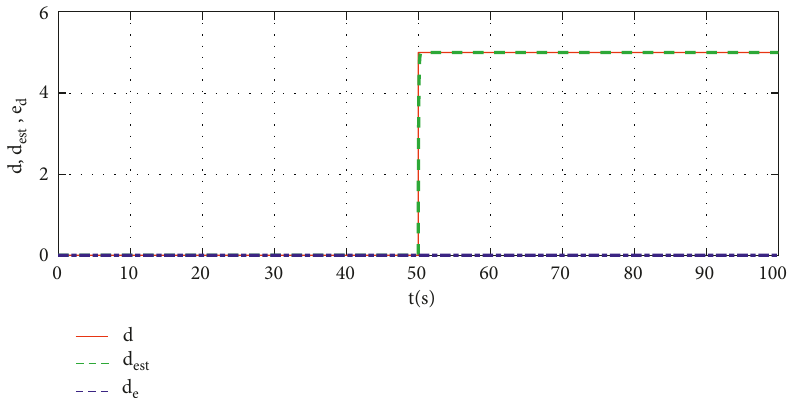
Figure 7: The applied disturbance d ( t ) , the estimated disturbance 􏽢 d ( t ) , and the disturbance error e